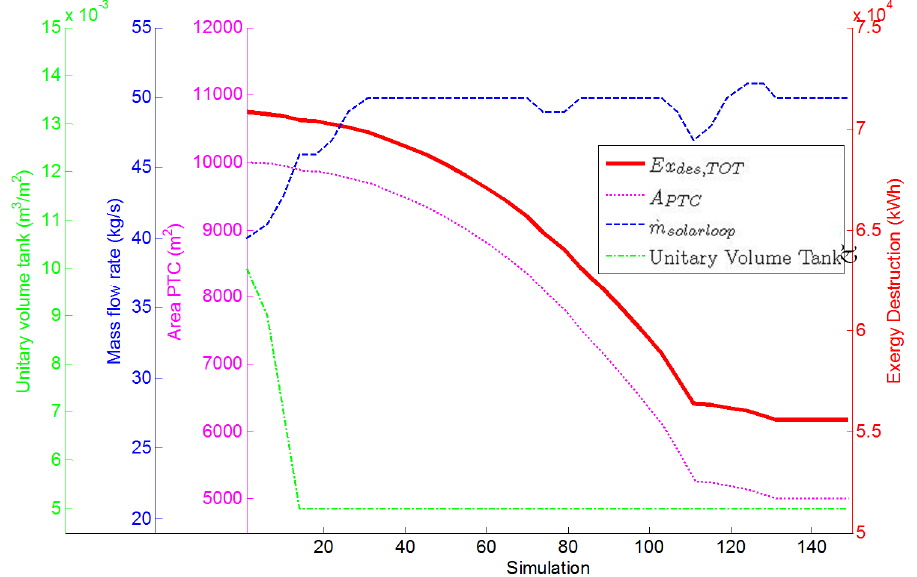
Figure 17. Optimization of the plant using the total exergy destruction as objective function.